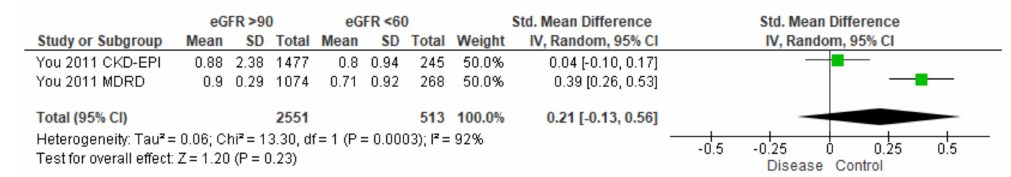
Figure 3. Difference of means of the groups elaborated from the MDRD and CKD-EPI formulas for the estimation of creatinine clearance